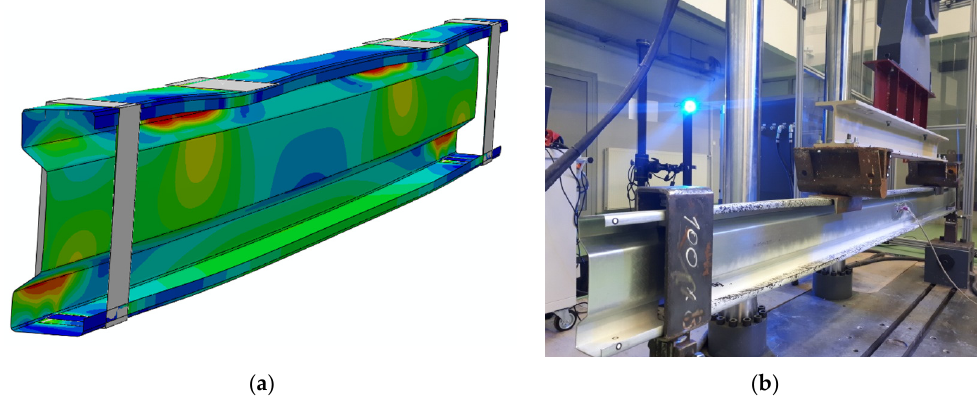
Figure 14. Beam deformation: ( a ) numerical analysis; ( b ) laboratory tests.